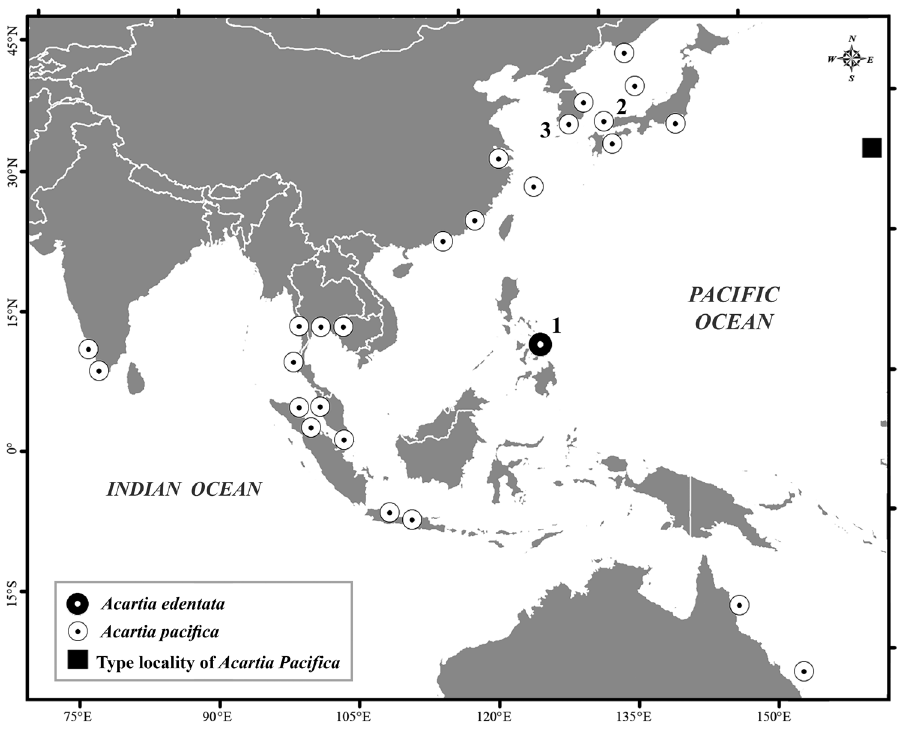
Figure 1. Distribution of Acartia ( Odontacartia ) pacifica and its sibling species based on data from this and previously published reports. In the present study, samples were obtained from three sites: Sta- tion 1, Acartia ( Odontacartia ) edentata sp. n., Leyte Island, the Philippines (black donut); Station 2, A. ( O. ) pacifica , Ariake Bay in the Seto Inland Sea, Japan (white donut); and Station 3, A. ( O. ) pacifica , South Korea Sea, Korea. Data from earlier studies indicate the distribution of A. ( O. ) pacifica in the Pacific Ocean (Steuer 1915; Tanaka 1965; Brodsky 1967; Ueda and Bucklin 2006); Korean waters (Kang 2011); the Yellow Sea, Chiekong River, Juilong Estuary, Changjiang Estuary, China (Shen and Lee 1963; Chen and Zhang 1965; Shang et al. 2007; Gao et al. 2008); eastern Indonesian waters of Java Sea, Bintulu coast, Indonesia (Früchtl 1923; Mulyadi 2004; Johan et al. 2013); the Gulf of Thailand (Pinkaew 2003); the Indian Ocean (Sewell 1933; Wellershaus 1969; Pillai 1971; Resai et al. 2004; Phukham 2008; Treer- amaethee et al. 2013); water of the Great Barrier Reef, Moreton Bay, Australia (Farran 1936; Greenwood 1978); and type locality of A. ( O. ) pacifica (black were preserved with a 4% neutral buffered formalin/seawater solution, while those for DNA analysis were fixed in 99.5% ethyl alcohol. Adult acartiids were sorted from the original samples under a stereomicroscope (Olympus SZX16, Olympus, Tokyo, Ja- pan). Specimens were dissected using a stainless steel pin (no. 00), and transferred to a polyvinyl lactophenol solution. Morphological features were measured directly with an ocular micrometer, and were drawn using a camera lucida attached to a compound mi- croscope (Olympus BX53, Olympus, Tokyo, Japan). Male and female urosomites of the new species were examined with a scanning electron microscope (JSM-6510LV,